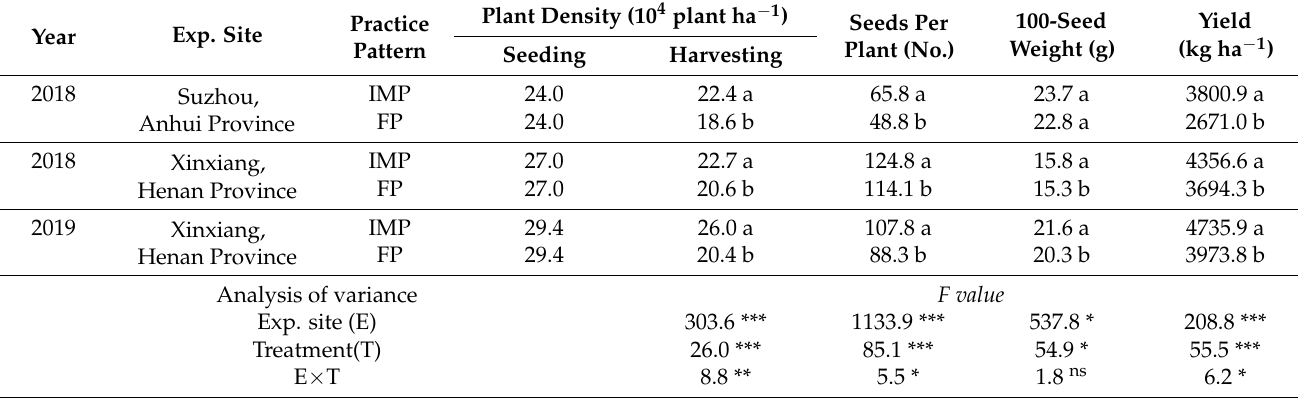
Figure 7. The effects of seeding management practices on photosynthetic rate ( P n ) for soybean. IMP, integrated management practice; FP, farmers’ practice. The upper and lower box edges of the box represent the 25th and 75th percentiles of all the data, respectively; the bottom and top bars represent the 5th and 95th percentiles, respectively; the solid black dots are outlier. ( A – D ) and ( E – H ) represent P n of soybean at Xinxiang site in 2018 and 2019, respectively. Table 3. The effects of seeding management practices on soybean yield and yield